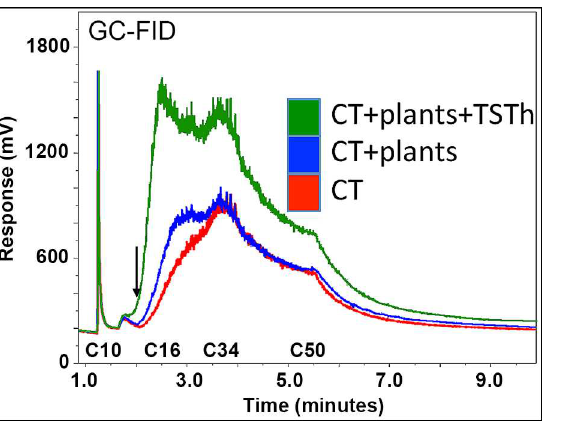
GC-FID assay we used was quantitative for petrochemicals with fewer than 50 carbons (C50), and qualitative for larger molecules [32]. The petrochemical residue in CT likely includes large, recalcitrant petrochemicals [10, 12], some of which are > C250 [12]. Compared to CT alone (Fig 6, area under the red [lowest] trace), CT supporting plant growth (Fig 6, area under the blue [middle] trace) had more C16-C32 content. Notably, plants